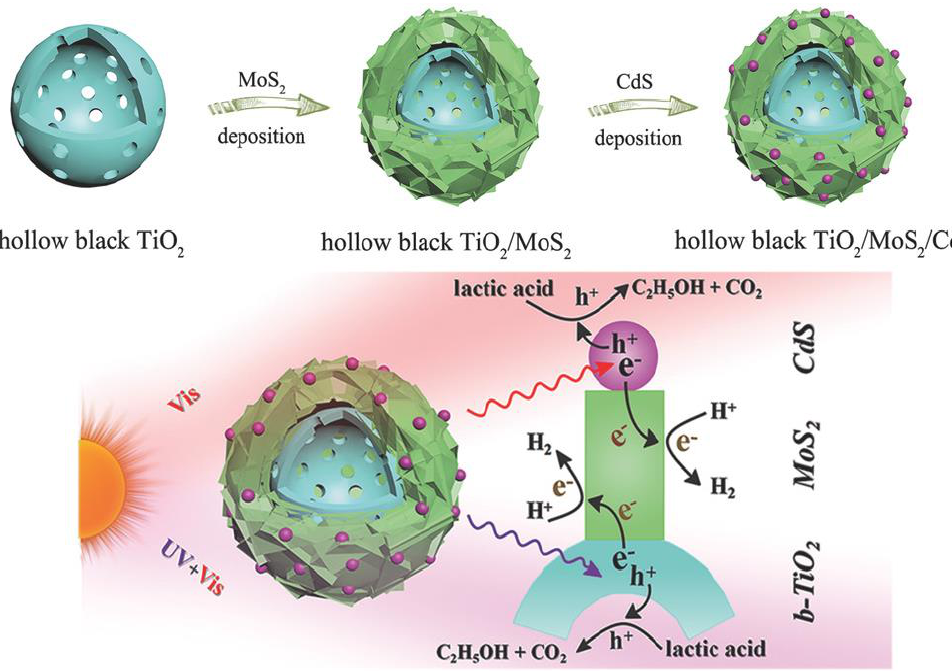
Figure 10. The synthesis process of particulate b–TiO 2 /MoS 2 /CdS tandem heterojunctions and schematics of the b–TiO 2 /MoS 2 /CdS tandem heterojunctions used for solar-driven water splitting. Reproduced from [147] . Copyright (2018), published by Wiley-VCH Verlag GmbH & Co. KGaA, Weinheim.